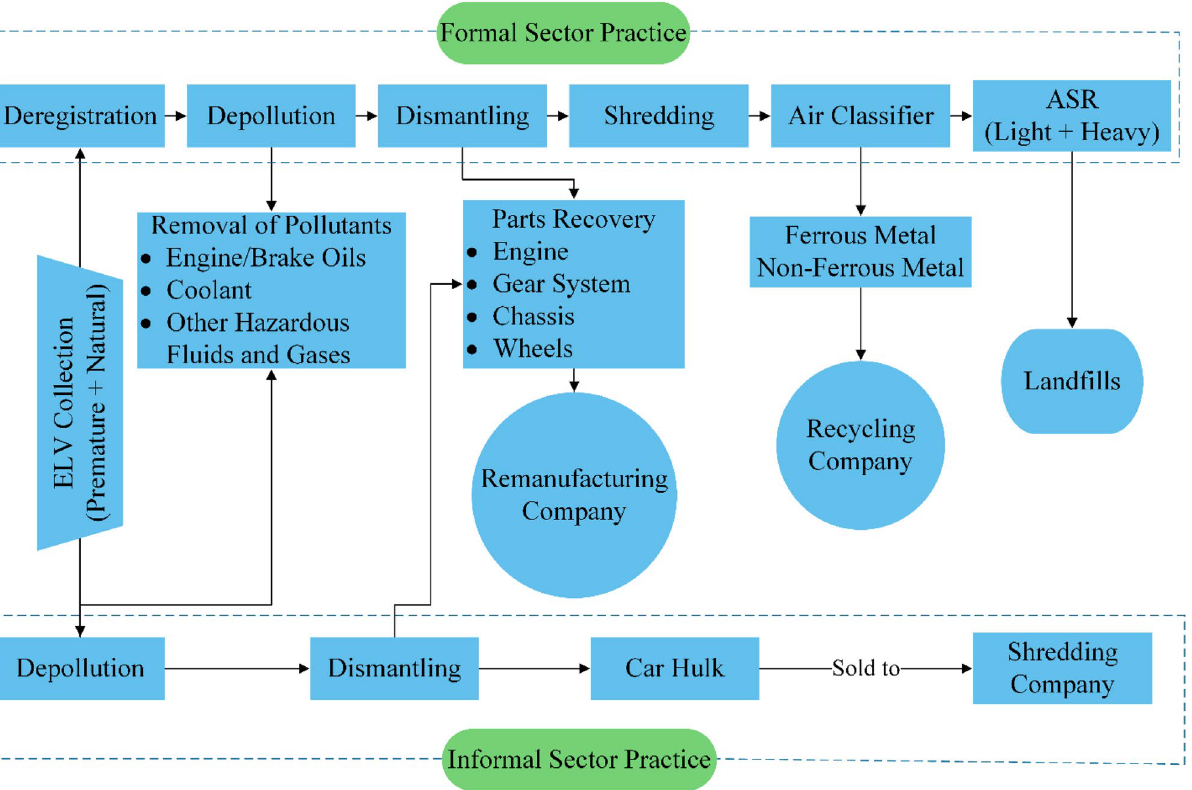
Figure 3. The present ELV recycling practices, including formal and informal sectors in India. Adopted and redrawn from authors own source 25